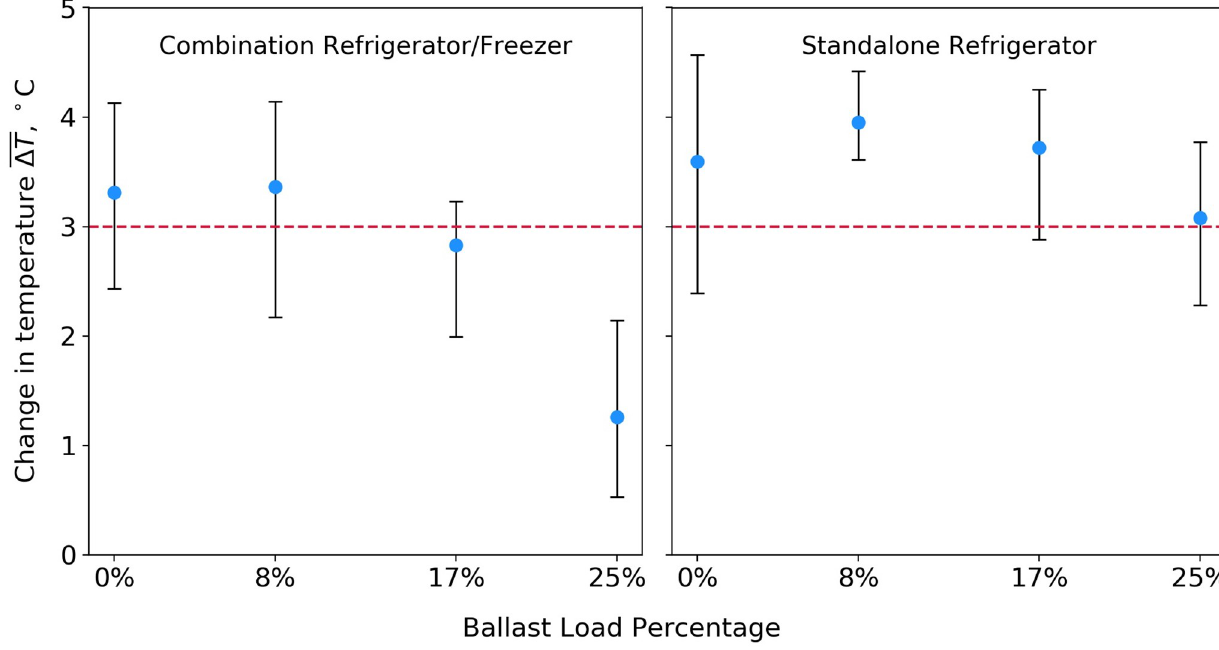
Fig 5. Refrigerator cabinet temperature changes during repeated door opening trials performed with varying thermal ballast load percentages. Round blue markers indicate the average temperature rise of all monitored vaccines during each trial, and error bars show the range of these measurements, corresponding to the within-trial variation among monitored